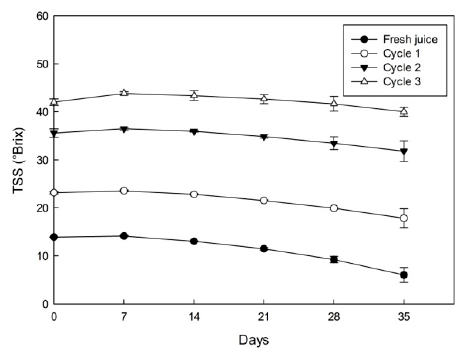
Figure 1. E ff ect of storage on TSS in fresh and cryoconcentrated calafate